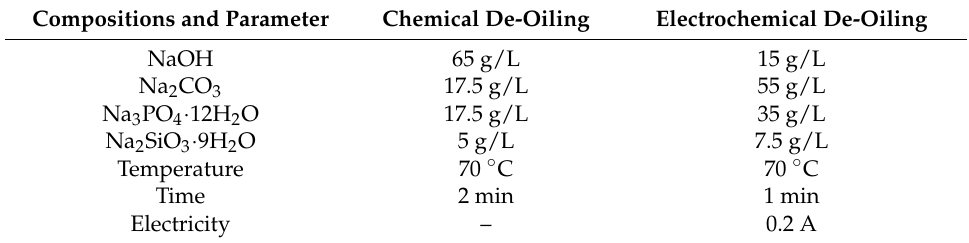
Table 1. Composition of degreasing solution and process parameters.